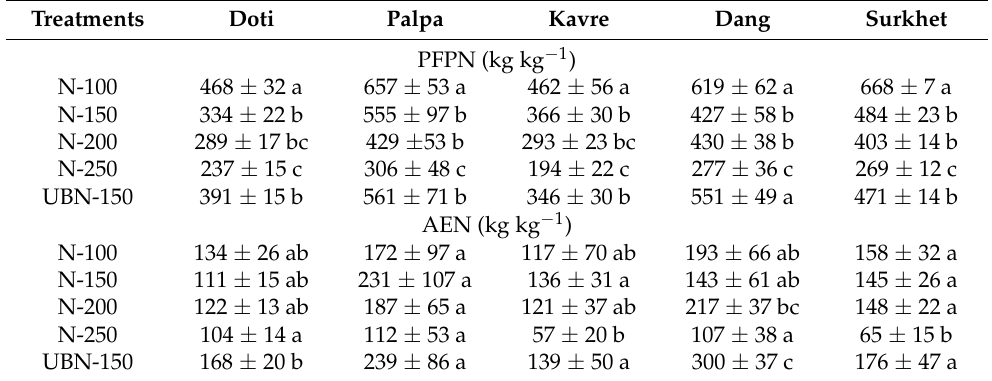
Table 3. Partial factor productivity of N (PFPN) and agronomic N use efficiency (AEN) across districts; mean ± SE. Means followed by different letters within a column of each district represent significant differences between the treatments (post hoc Tukey test, p < 0.05).